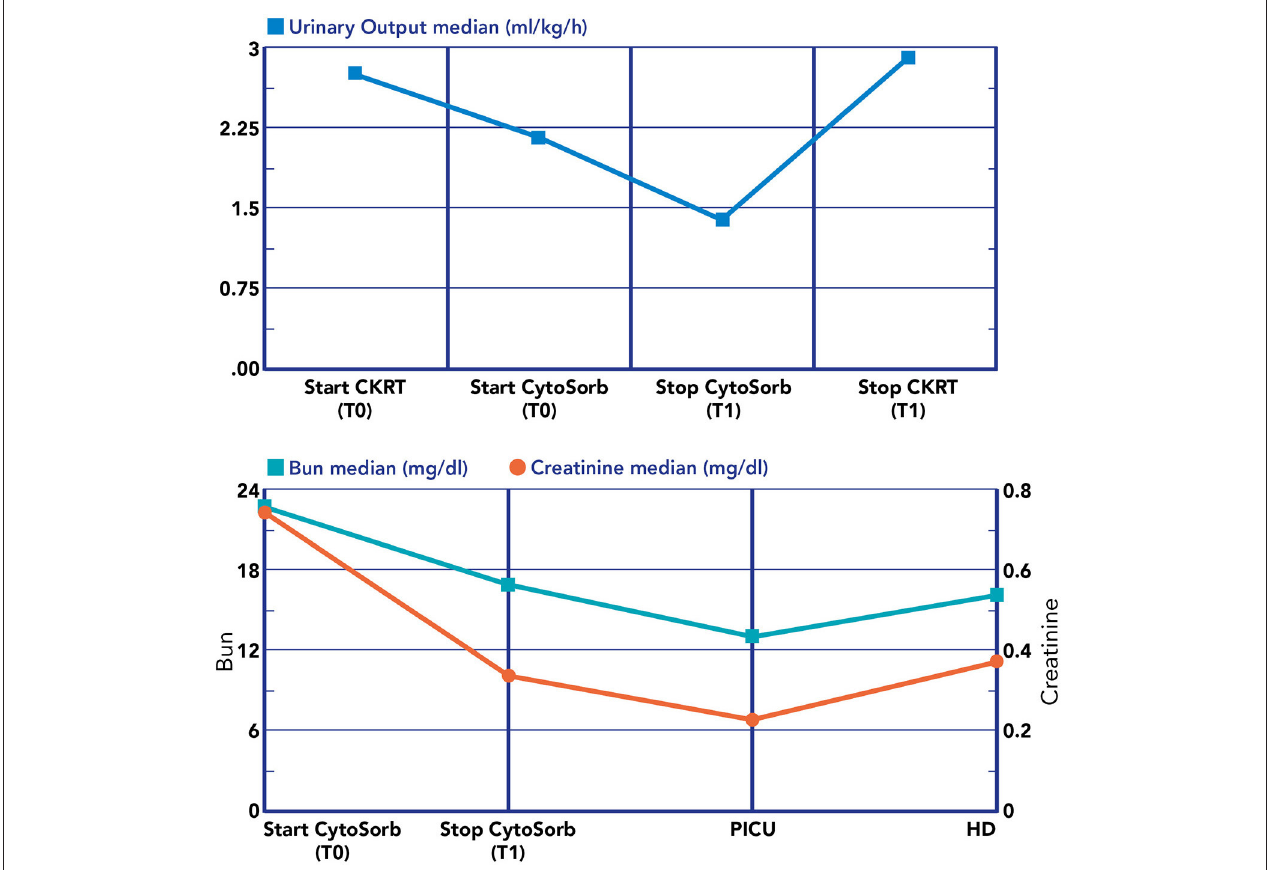
FIGURE 6 | Renal biomarkers and urine output during the blood purification journey. Lower section : T0, immediately before the start of CRRT plus hemoperfusion with CytoSorb; T1, after the stop hemoperfusion with CytoSorb; PICU, at PICU discharge; HD, at hospital discharge.